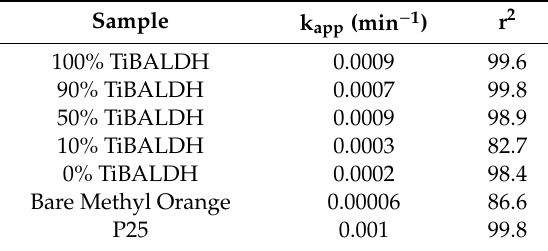
Figure 8. The degradation rate of methyl orange by annealed fibers in ( a ) UV light, and ( b ) visible light. Table 3. Reaction rate constant and r 2 values for the photocatalytic degradation of methyl orange in UV light.